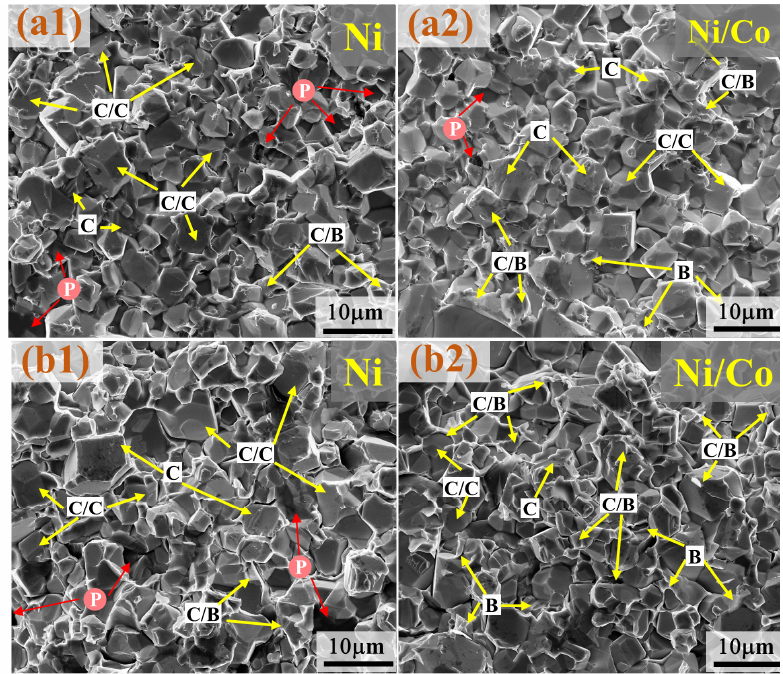
Figure 4. Fracture morphology of WC-Ni/Co cemented carbide: ( a1 , a2 ) WC-Ni/Co EP ; ( b1 , b2 ) WC-Ni/Co CP.